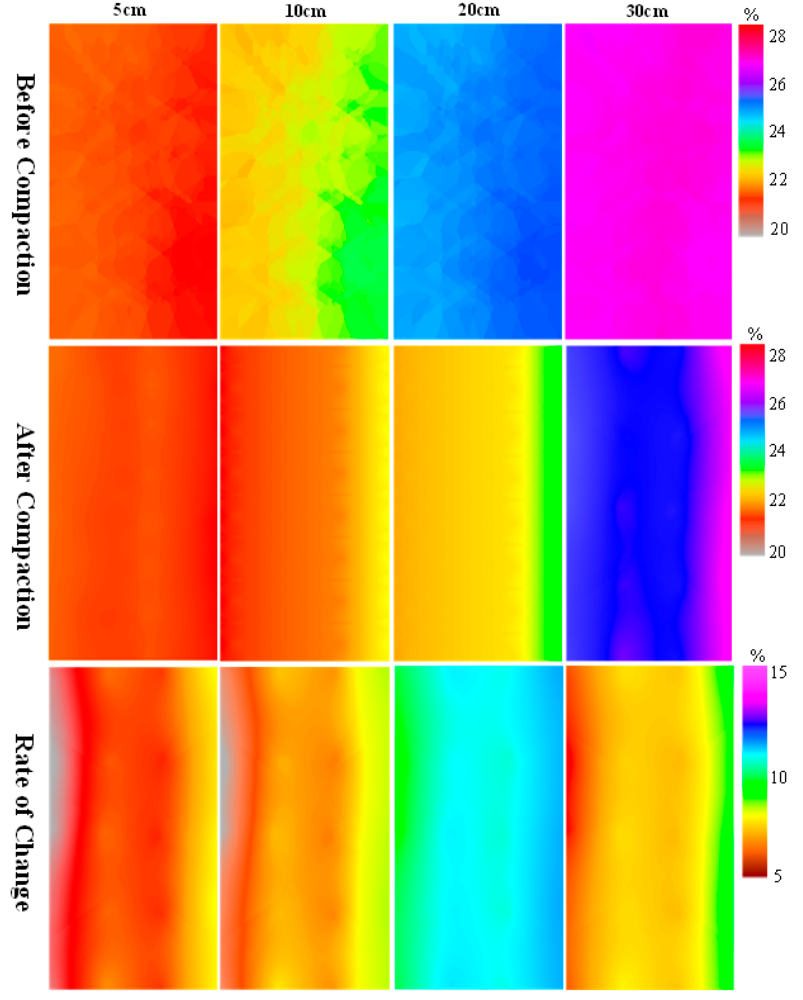
Figure 12. Transverse spatial distribution of soil moisture content at each depth before and after compaction .